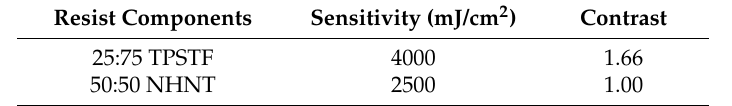
Figure 4. Mo 8 blend contrast curves using UV exposure (365–412 nm).